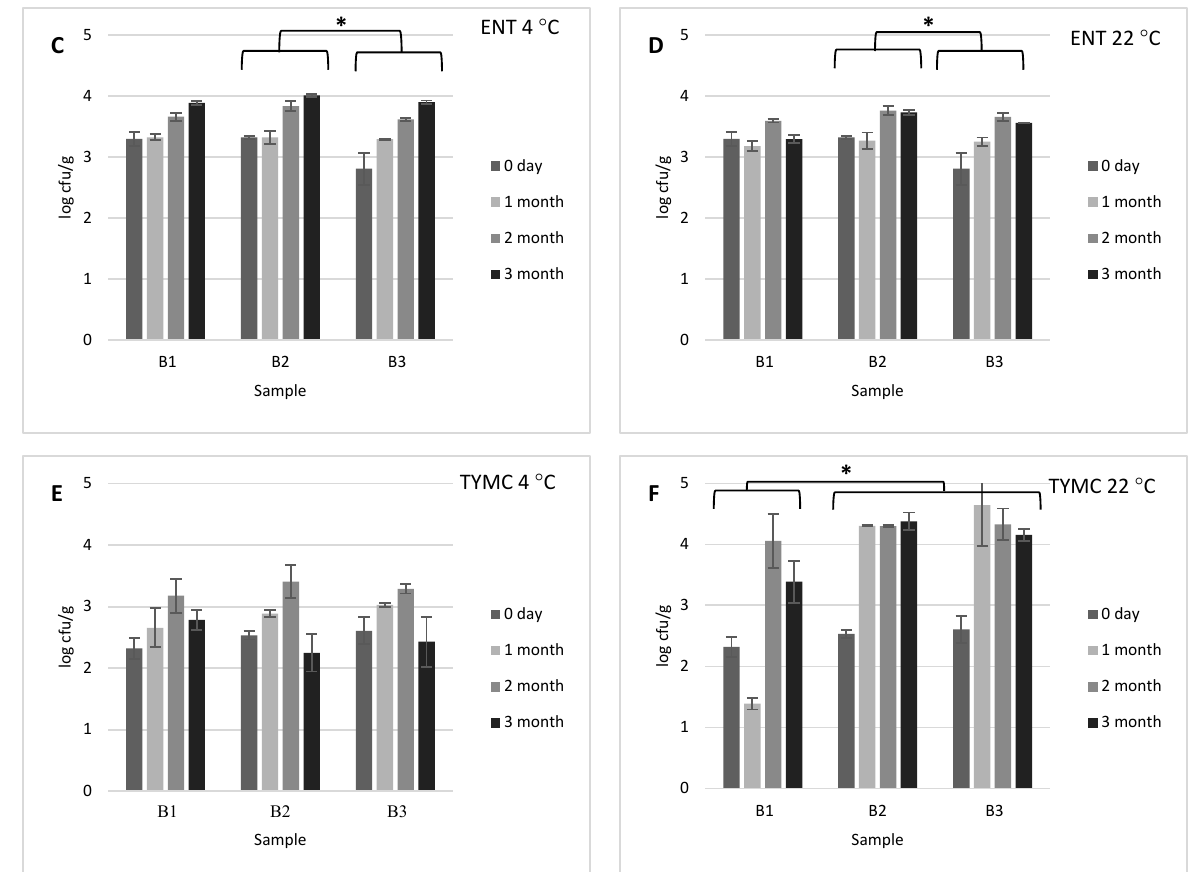
Figure 1. Mean number of selected microorganisms in the organic high-protein bars samples (B1, B2 and B3) stored for 3 months at 4 or 22 °C. ( A , B ) Total number of microorganisms (TVC); ( C , D ) number of Enterobacteriaceae (ENT); ( E , F ) count of yeasts and moulds (TYMC). n = 3. Values of the variants of the product (B1, B2, B3) marked with an asterisk differ significantly according to the post hoc Bonferroni test ( p < 0.05). Bars represent mean standard error.